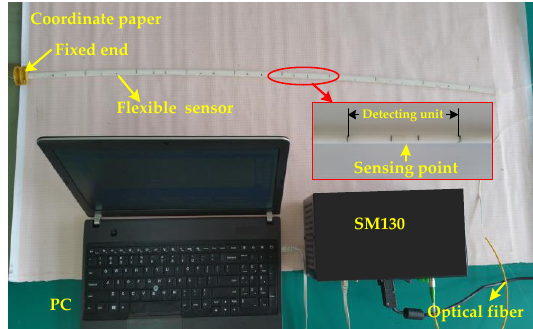
Figure 6. Schematic diagram of experimental facility.